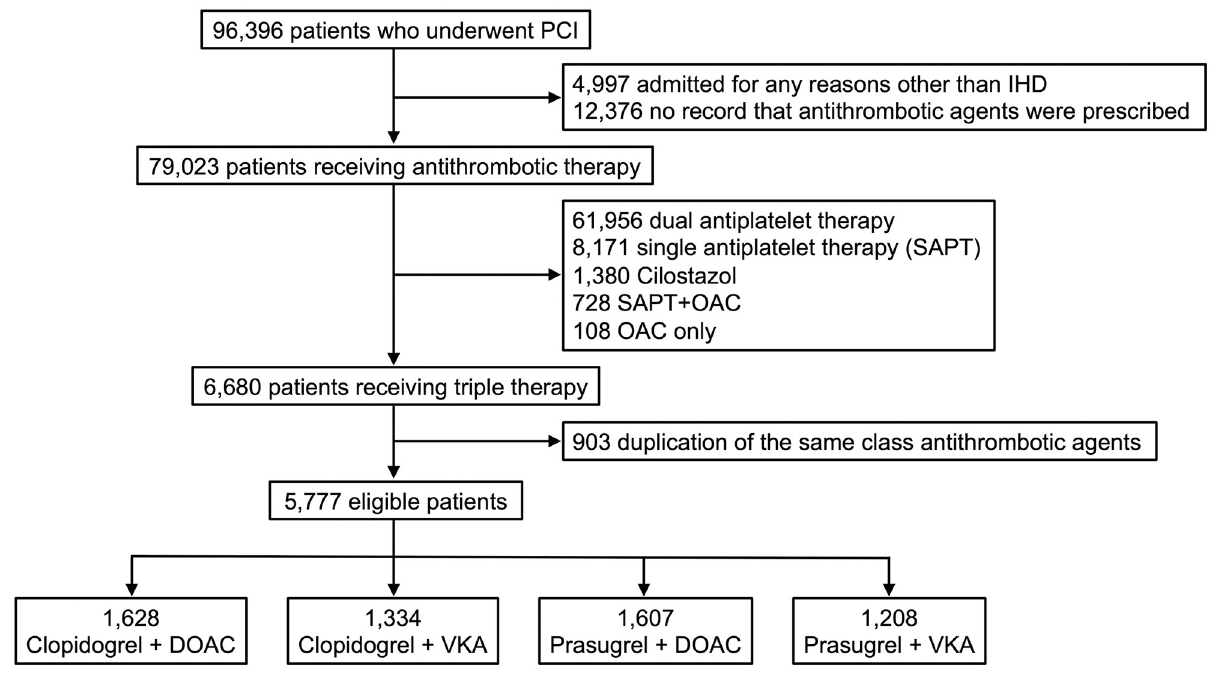
Fig 1. Flowchart for patient selection in the present study. DOAC: direct oral anticoagulant, IHD: ischemic heart disease, OAC: oral anticoagulant, PCI: percutaneous coronary intervention, SAPT: single antiplatelet therapy, VKA: vitamin K antagonist.